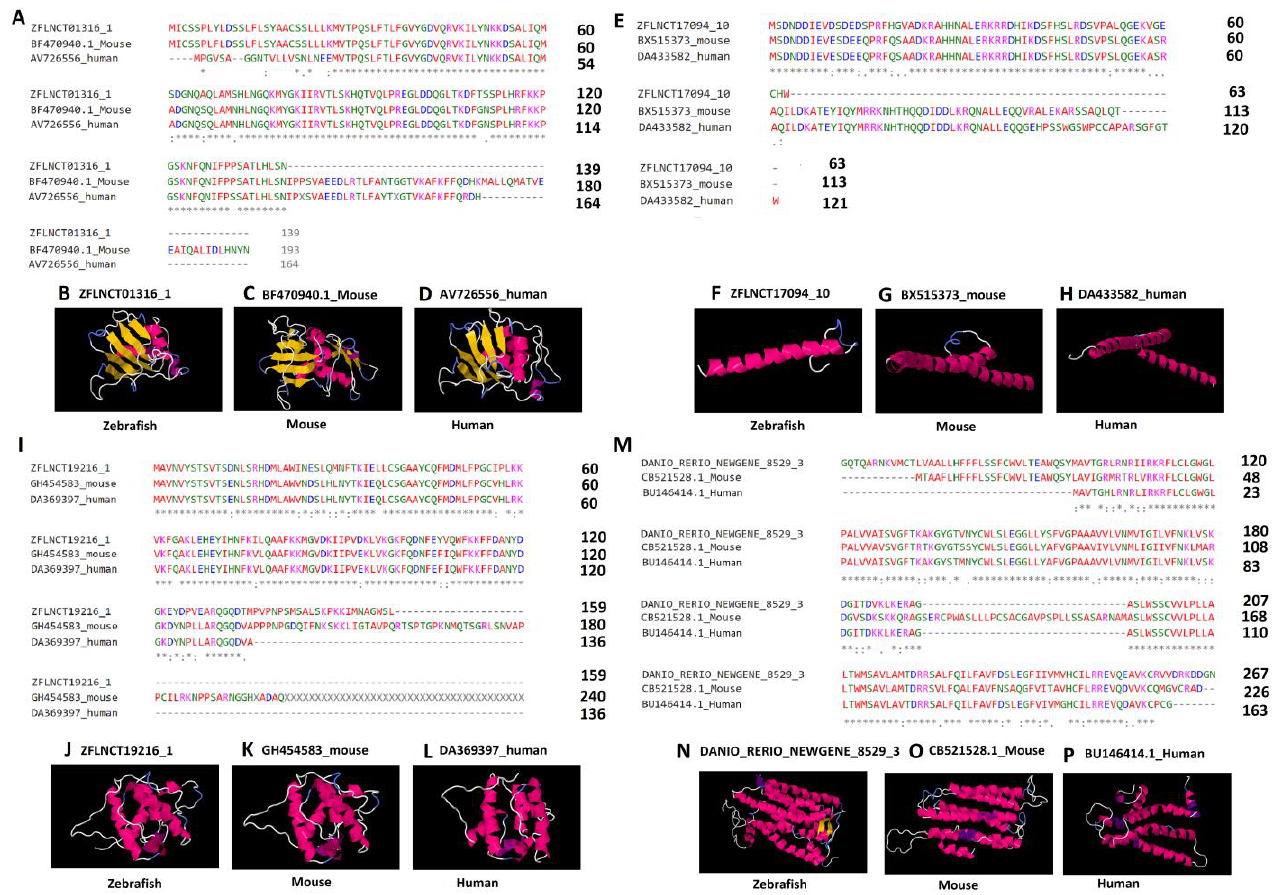
Figure 6. Multiple sequence alignment and three-dimensional structures predicted by (PS)2-v2: protein structure prediction server for the highly conserved lncRNA-encoded peptides among zebrafish, humans, and mice. Pineal gland lncRNA-encoded peptides ( A – L ) and testis lncRNA-encoded peptides ( M – P ). The asterisk symbols ( A , E , I , M ) depict the identical amino acids among the peptides encoded by zebrafish lncRNAs (ZFLNCT01316_1, ZFLNCT17094_10, ZFLNCT19216_1, and DANIO_RERIO_NEWGENE_8529_1), as well as their corresponding mouse orthologs (BF470940.1_Mouse, BX515373_mouse, GH454583_mouse, and CB521528.1_Mouse) and human orthologs (AV726556_human, DA433582_human, DA369397_human, and BU146414.1_Human). The 3D models of the peptides ( B – D , F – H , J – L , N – P ) represent the conservation of α-helix (pink or purple motif structure), β-strand (yellow layered band), and random coils (white or blue thread) among zebrafish, humans, and mice with known domains from the Protein Data Bank, such as, B (2adcA), C (2adcA), D (2adcA), F (1nkpB), G (1nkpB), H (1nkpB), J (1wyoA), K (1wyoA), L (1wyoA), N (1u19A), O (2vt4B), and P (1xioA).